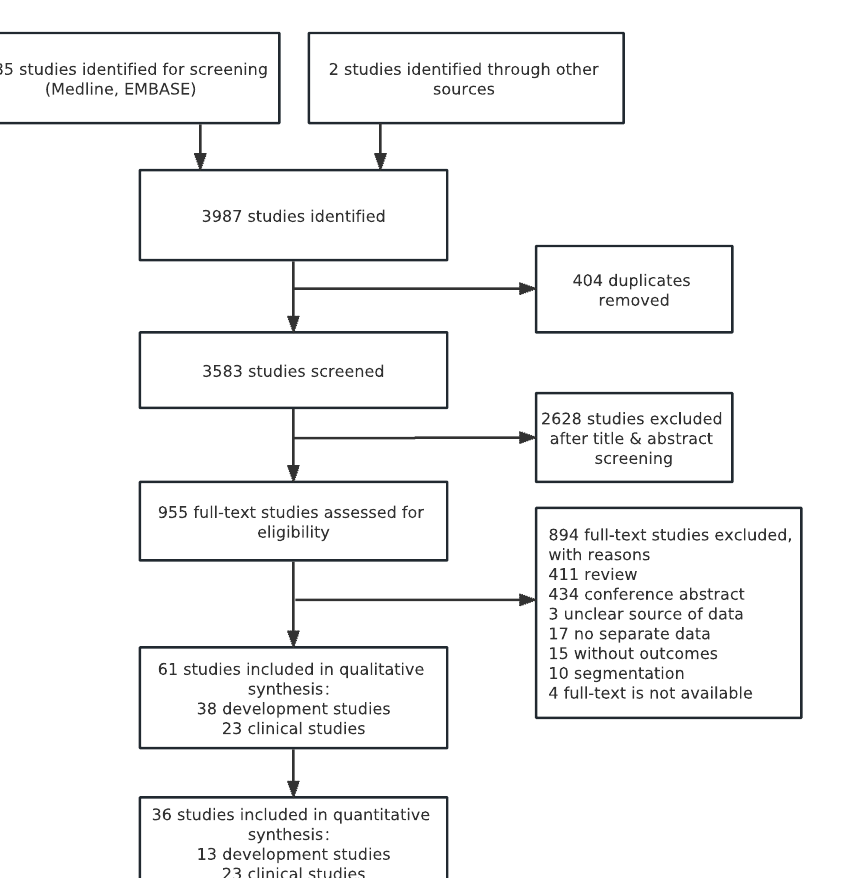
Figure 1. Study flow diagram. Computer-aided detection (CAD). Table 1. Methods of studies included in descriptive analysis.